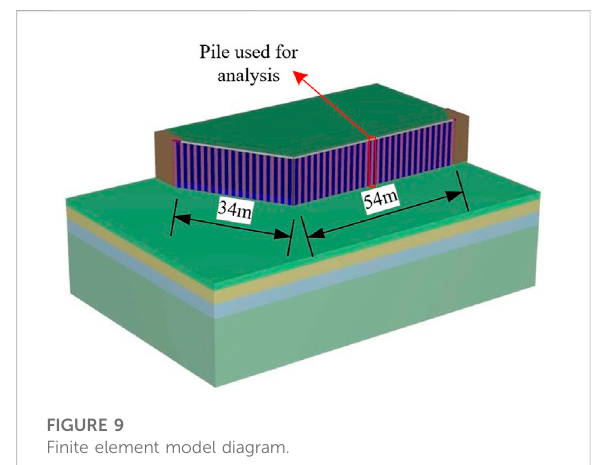
FIGURE 9 Finite element model diagram.